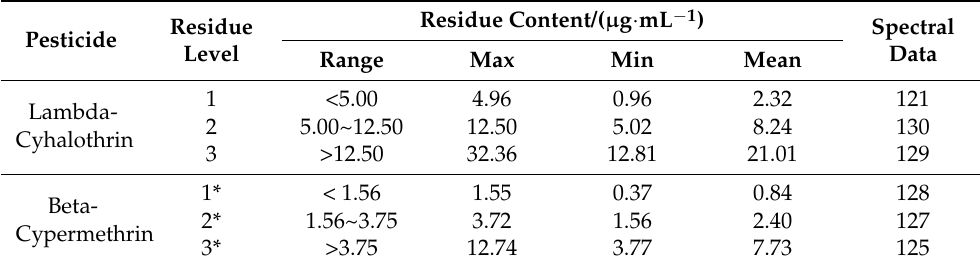
Table 4. Spectral data distribution in three-level discrimination of pesticide residues.